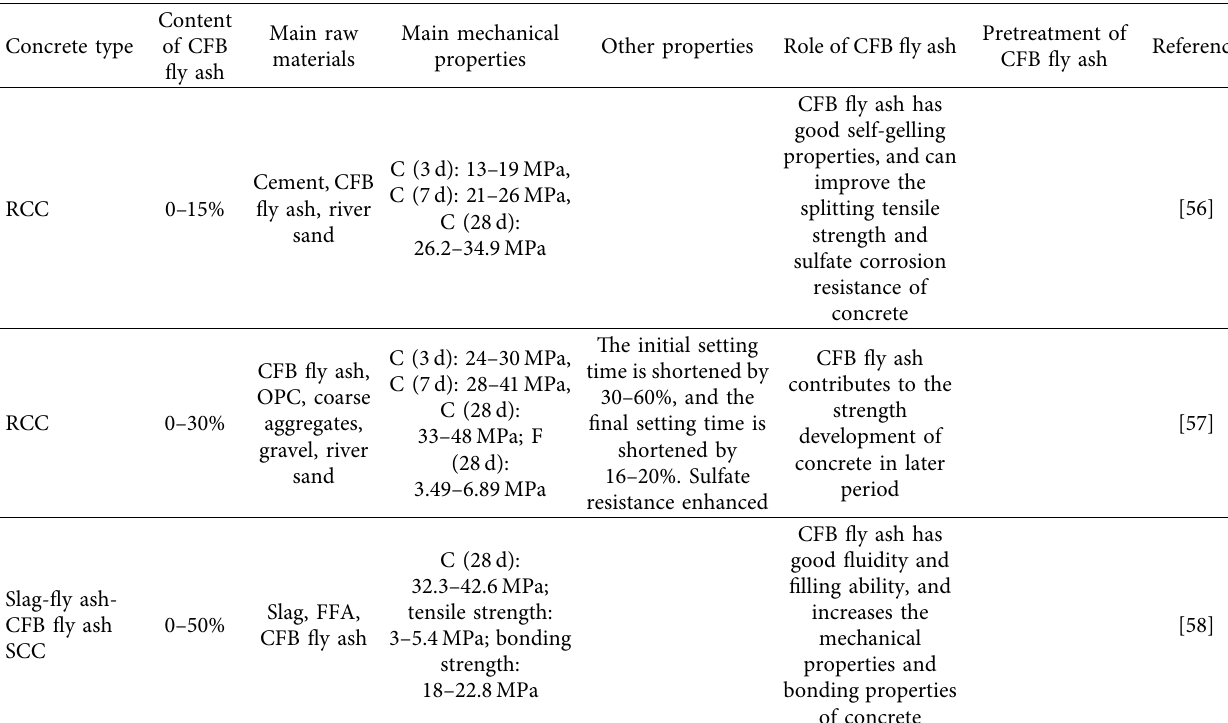
Table 6: Application of CFB fy ash in normal